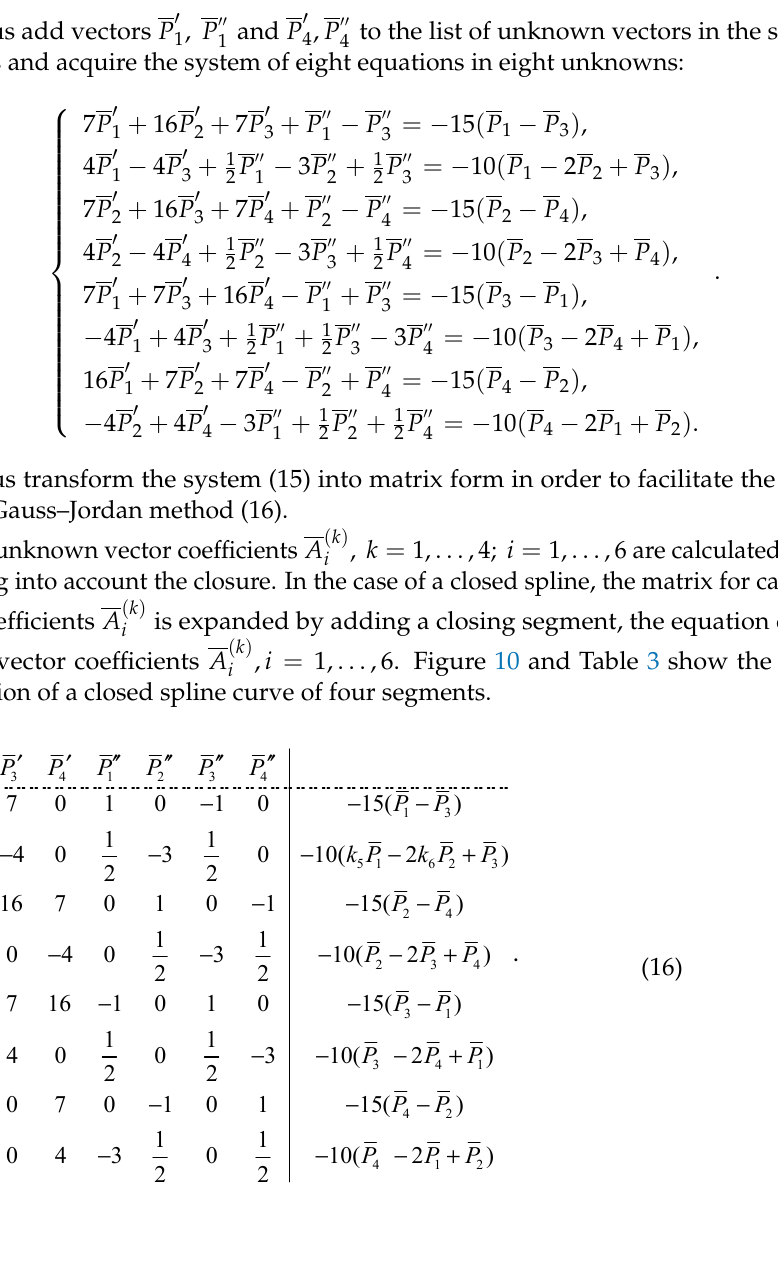
Figure 10. Closed fifth-degree Hermite spline curve of four